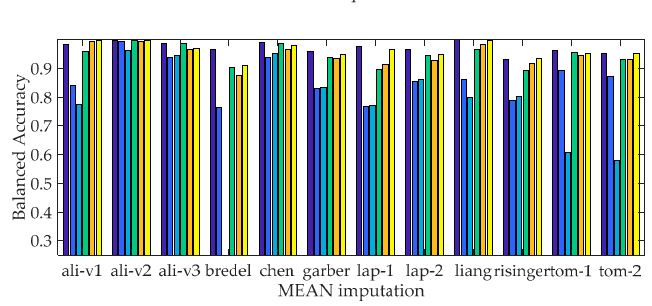
Figure 2. Comparison of balanced accuracies with three imputation methods,